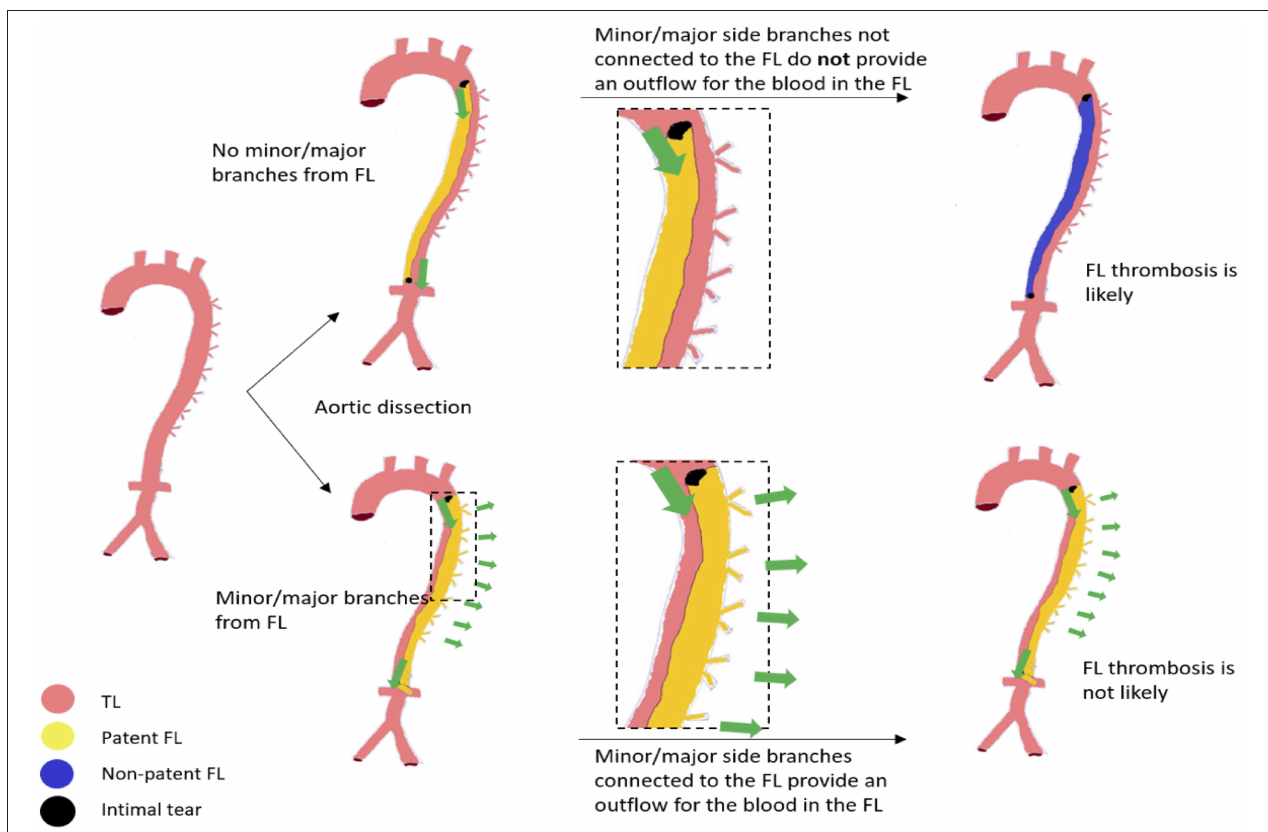
FIGURE 6 | Schematic illustration of the proposed mechanism determining false lumen (FL) patency driven by small side branches. Intimal tears are black, while green arrows indicate FL blood flow. Left: healthy aorta with no tears and no aortic dissection (AD). At the time of AD, a FL and true lumen (TL) is created through delamination of the aortic wall. Note that more than one intimal tear may occur. Upper panel: No side branches originate from the FL; all minor side branches originate from the TL. Here, the outflow is limited via re-entry tears. Stasis of blood flow is likely which might initiate FL thrombosis. Lower panel: (Multiple) Minor side branches originate from the FL and provide a continuous outflow for the blood. FL thrombosis is less likely to be